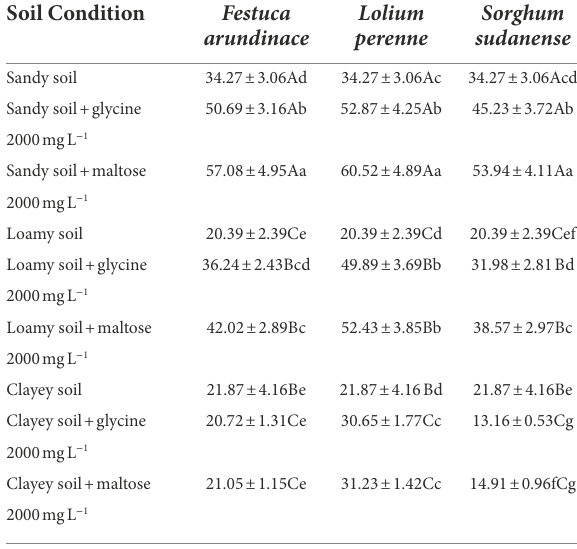
Data are the mean of three replicates ± SE. Differences sampled indicated by capital letter are between soil types, and by lower-case letter are exudates related. Means followed by the same letters are not significantly different at 5% according to Duncan’s multiple range